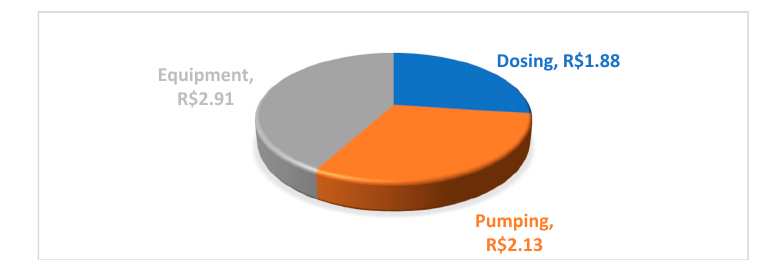
Figure 3. Total operating cost/m 3 . Data sourced from [52] .